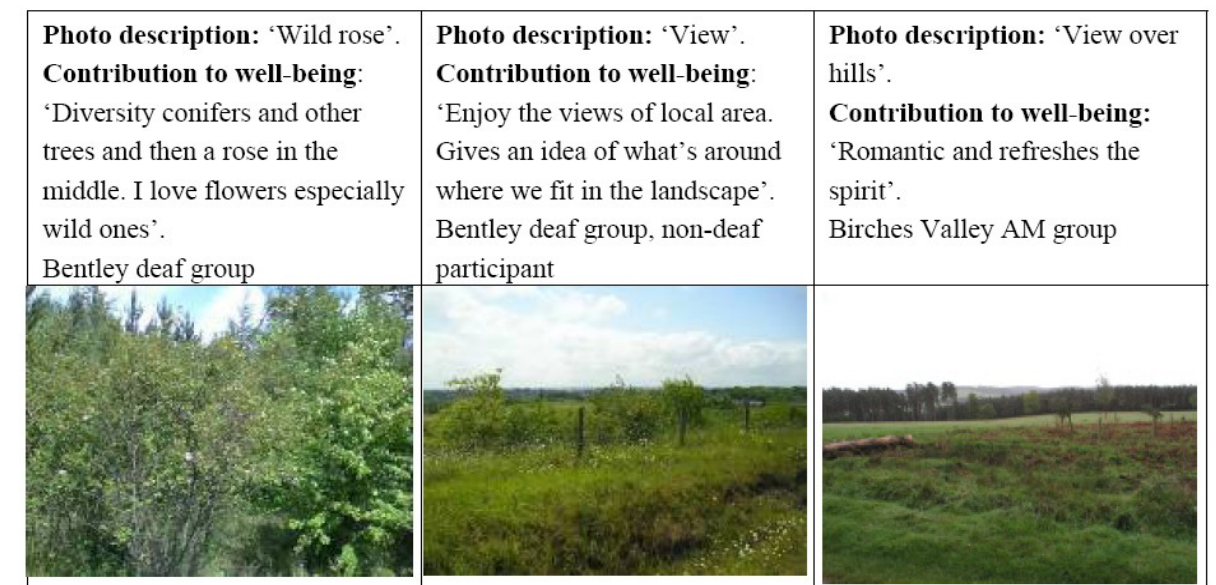
Figure 2. Variety and complexity in the woodland